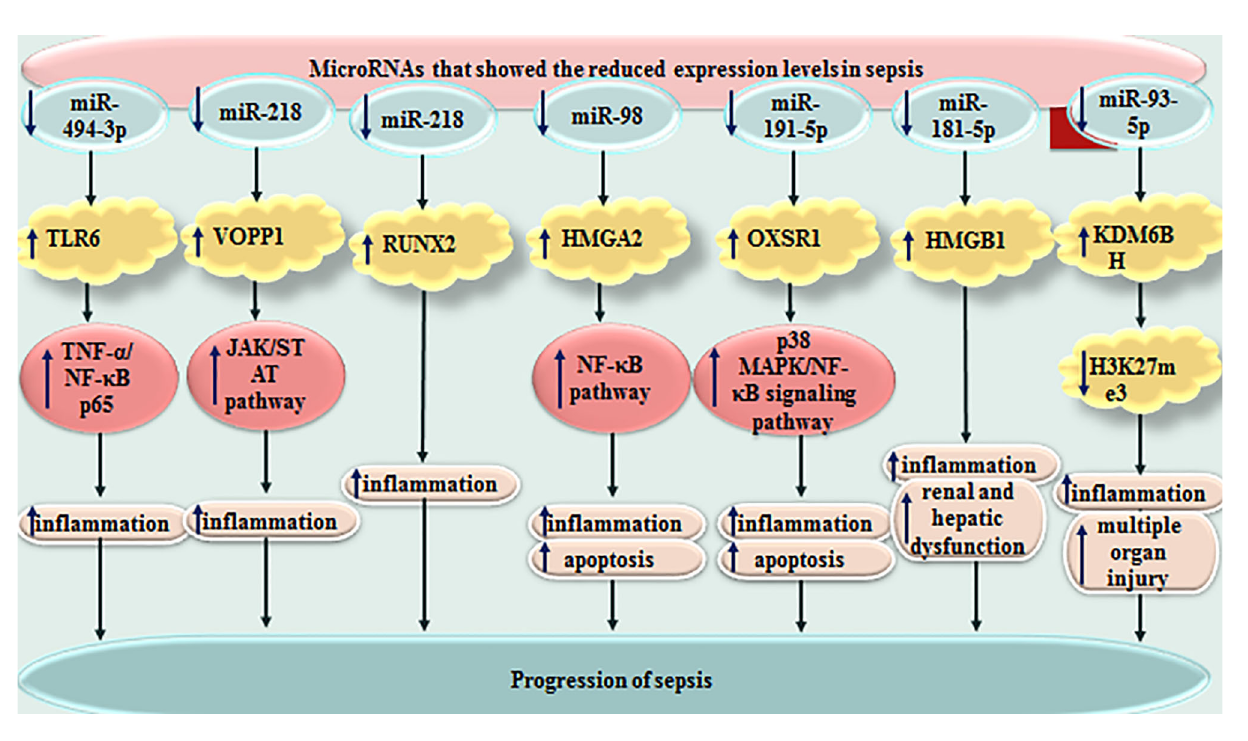
FIGURE 3 | Down-regulated miRNAs in